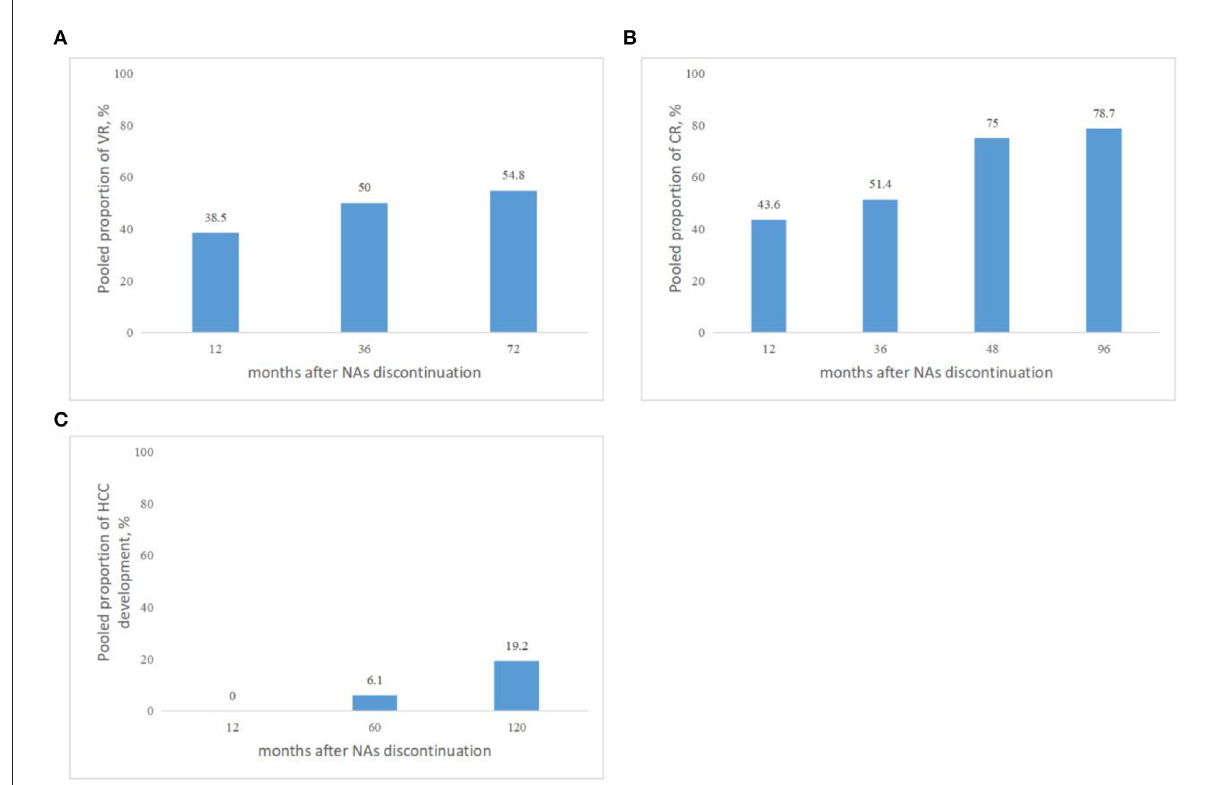
FIGURE3 (A) Pooled proportions of VR in cirrhotic patients after NAs discontinuation. VR was defined by serum HBV DNA levels > 2,000 IU/mL. (B) Pooled proportions of CR in cirrhotic patients after NAs discontinuation. CR was defined as ALT > 2 × ULN. (C) Pooled proportions of HCC development in cirrhotic patients after NAs